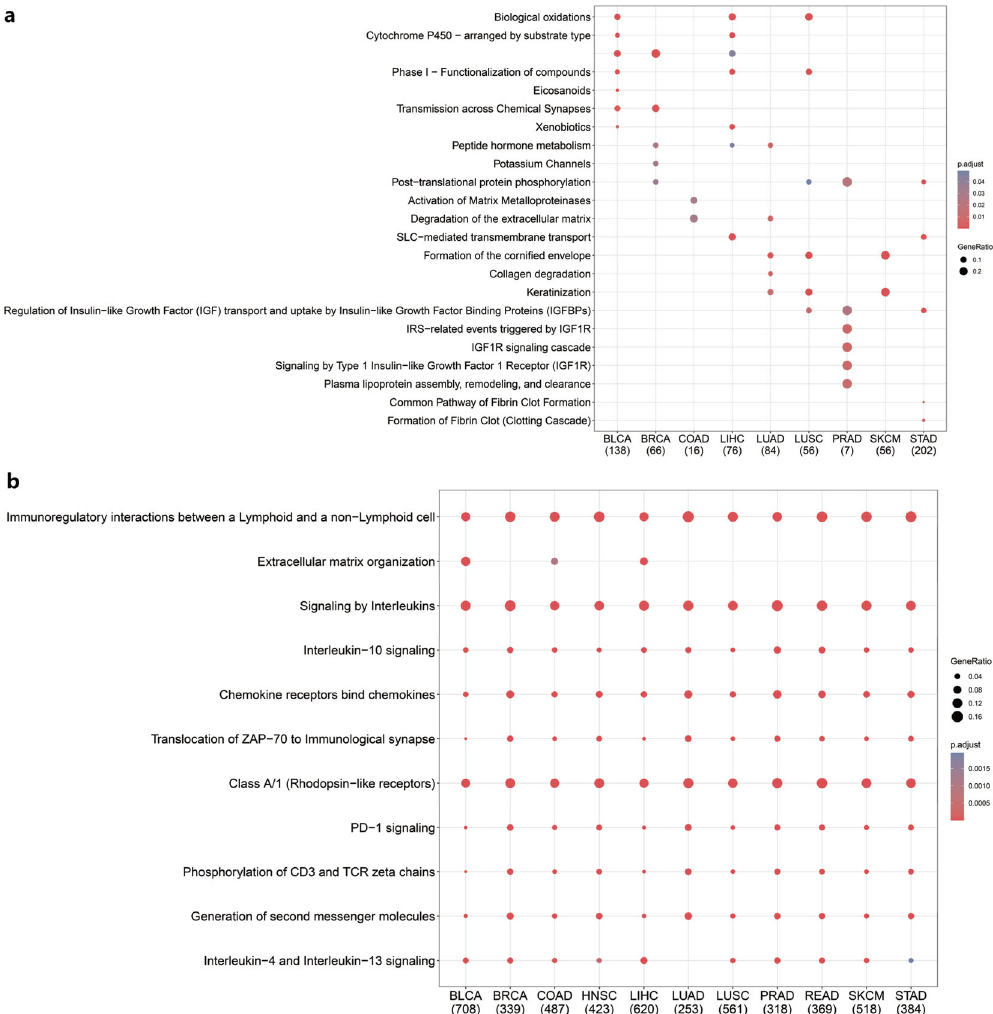
Fig. 3 Gene function analysis of in fl amed/nonin fl amed TME-speci fi c mRNA (with Reactome datasets). a Enriched biological process for nonin fl amed TME-speci fi c genes expressed across tumor types. b Enriched biological process for in fl amed TME-speci fi c genes expressed across tumor types. BLCA bladder urothelial carcinoma, BRCA breast invasive carcinoma, COAD colon adenocarcinoma, LIHC liver hepatocellular carcinoma, LUAD lung adenocarcinoma, LUSC lung squamous cell carcinoma, PRAD prostate adenocarcinoma, READ rectum adenocarcinoma, SKCM skin cutaneous melanoma, STAD stomach adenocarcinoma, HNSC head and neck squamous cancer (the number below the TCGA tumor type represents the number of identi fi ed genes in each category, the gene ratio represents the ratio of differentially expressed genes in the total pathway gene